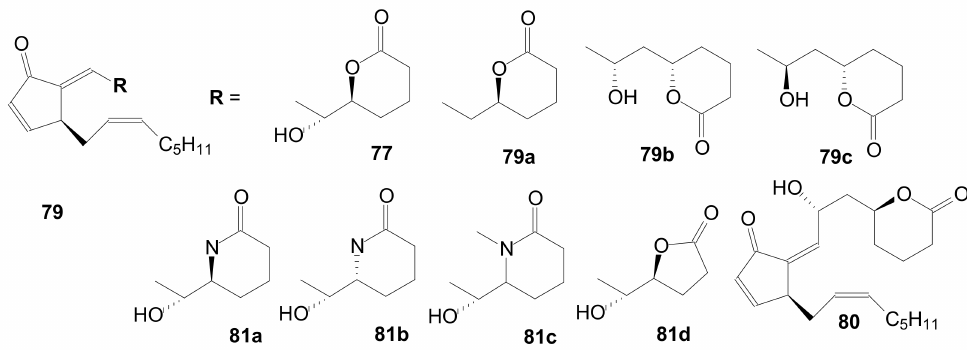
Figure 6. 1,5-Lactone and lactam analogs of the cyclo-EC 77 . 5,6-Epoxy-eicosatrienoic acid (5,6-EET, 82 ) is formed by cytochrome P450s oxidation